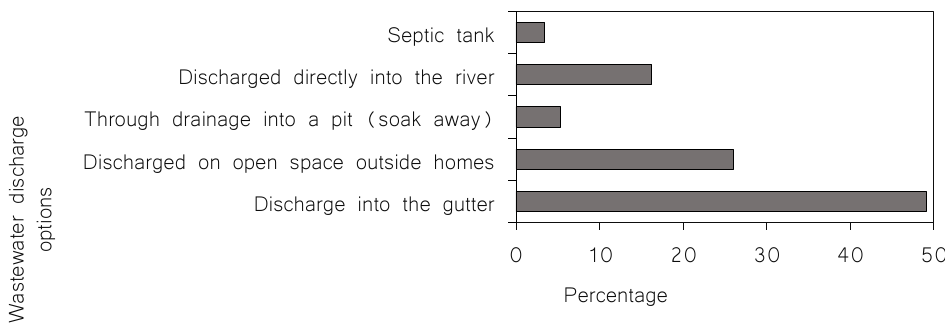
Figure 3. Wastewater management named by households. Data source: based on primary data collection, using household surveys in the Odaw River catchment in Ghana, in April 2019.